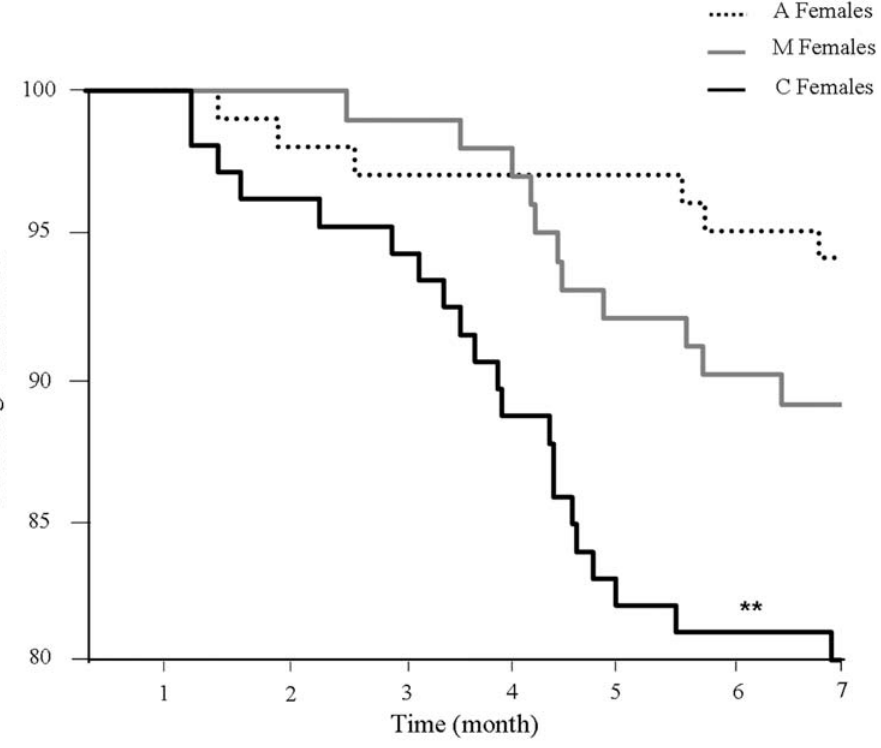
Figure 3. Effect of Wolbachia on host survival. Comparison of survival plots between A females, C females and M females during 7 months revealed that C females survived significantly less than A females and M females.